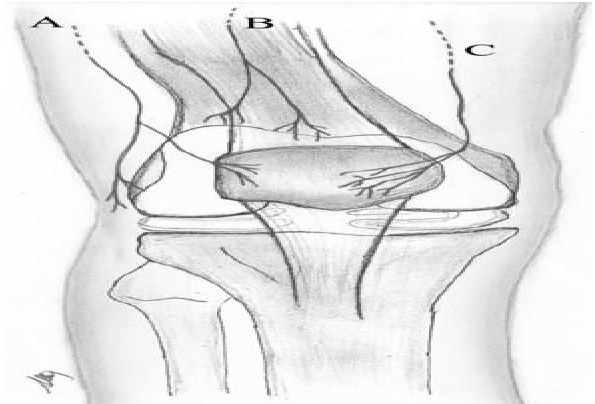
Figure (1): nerve supply around patellar region :(A) lateral cutaneous nerve of thigh, (B) anterior cutaneous nerve of thigh,(C) medial cutaneous nerve of thigh